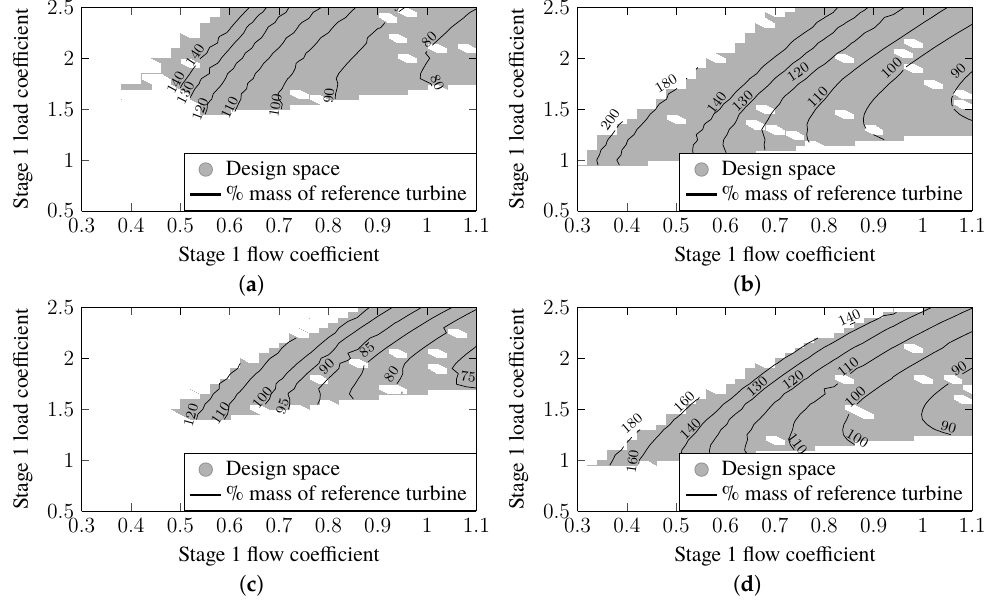
Figure 16. Mass comparison of low-pressure turbine design maps: ( a ) constant hub, two stages; ( b ) constant hub, three stages; ( c ) constant mean, two stages; ( d ) constant mean, three stages.